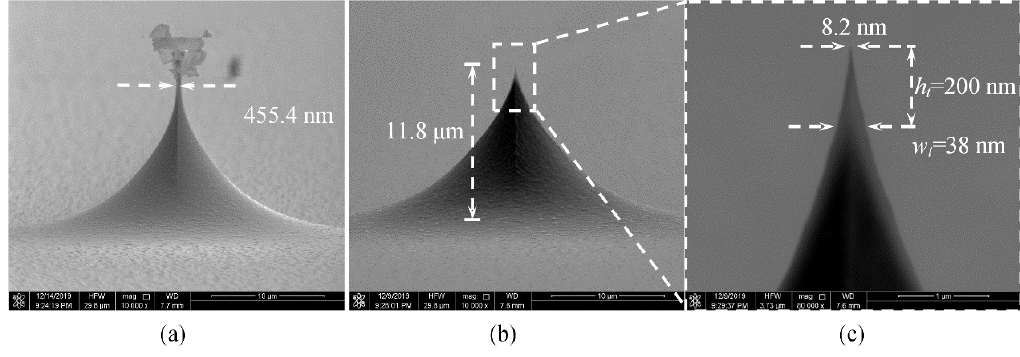
Figure 9. SEM images of pre-tip ( a ) and tip after oxidation sharpening ( b , c ).